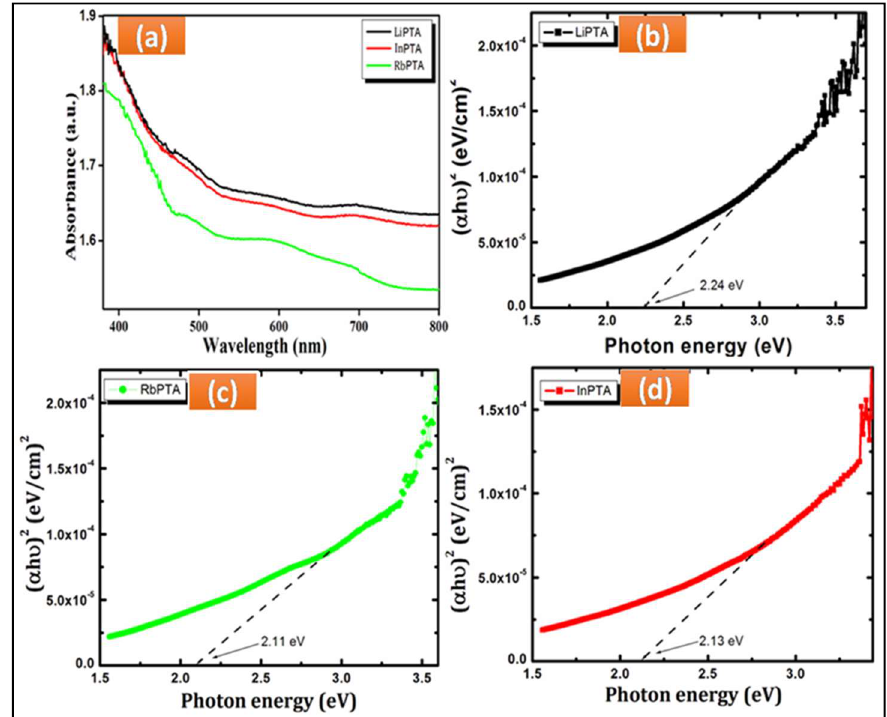
Figure 2. ( a ) Optical absorption spectra for Li−PTA, Rb−PTA, and In−PTA thin films and optical band gap of ( b ) Li−PTA ( c ) Rb−PTA, and ( d ) In−PTA thin films. band gap of ( b ) Li − PTA ( c ) Rb − PTA, and ( d ) In − PTA thin films.